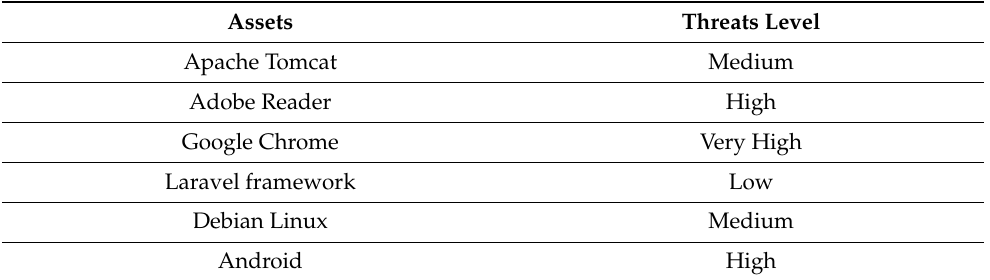
Table 11. Some examples of the threat level identified for some assets in the